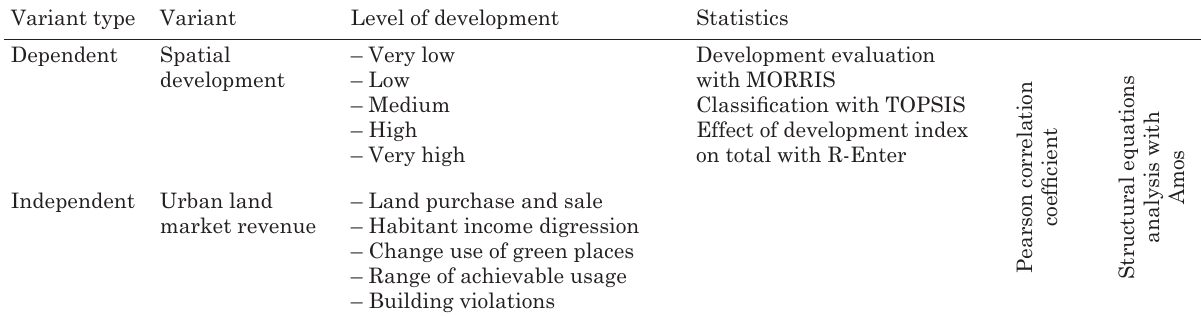
Table 1. Analytic relation between measurable variants in a studied confine Variant type